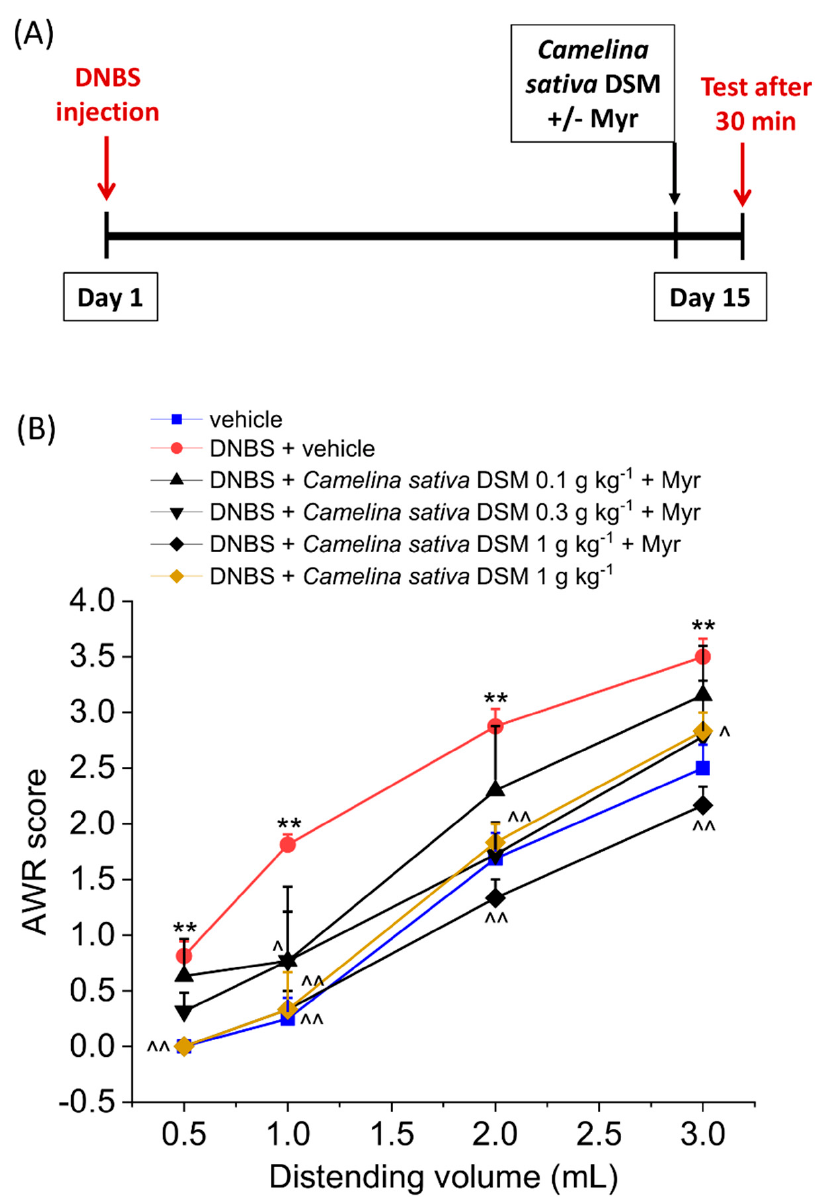
Figure 1. The effect of Camelina sativa DSM acute administration on visceral pain associated with colitis in rats before and after bio-activation with myrosinase enzyme (Myr). ( A ) Experimental scheme: the behavioural test was performed 30 min after the oral administration of the Camelina sativa DSM (0.1–1 g kg − 1 p.o.). Camelina sativa DSM was bioactivated by adding 30 µ L mL − 1 of myrosinase (32 U mL − 1 ) 15 min before the administration. ( B ) Visceral sensitivity was assessed in animals by measuring the extent of the abdominal withdrawal response (AWR) to colorectal distension, carried out by applying an increasing distending stimulus on the colon walls (0.5–3 mL). Each value represents the mean ± SEM of six animals per group. ** p < 0.01 vs. vehicle. ˆ p < 0.05 and ˆˆ p < 0.01 vs. DNBS +